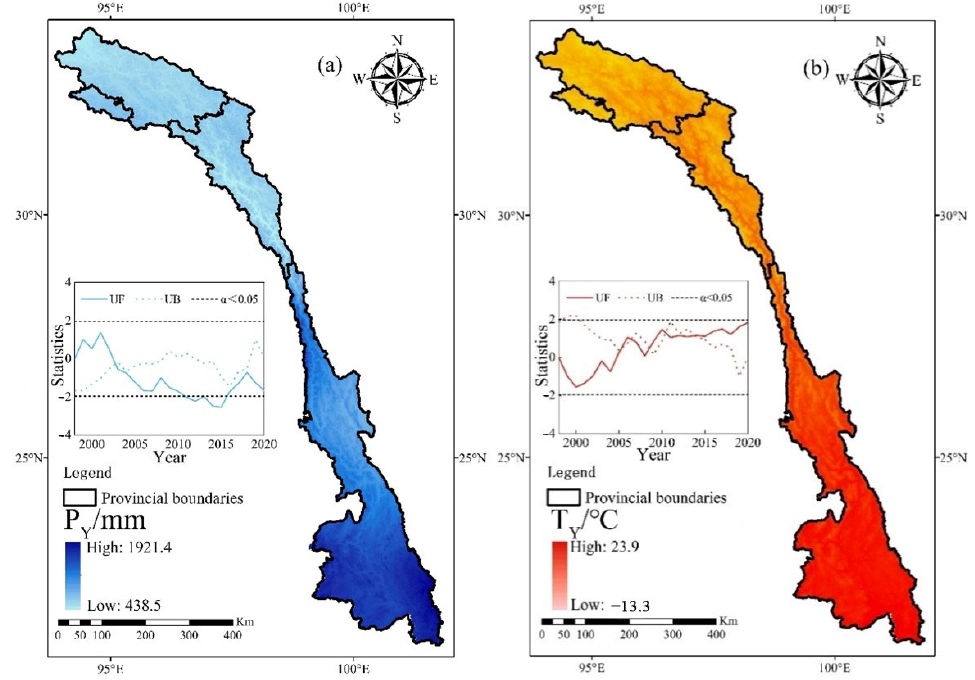
Figure 6. Distribution of annual average precipitation and temperature. ( a ) Distribution of annual average precipitation and M–K test of precipitation. ( b ) Distribution of annual average temperature and M–K test of